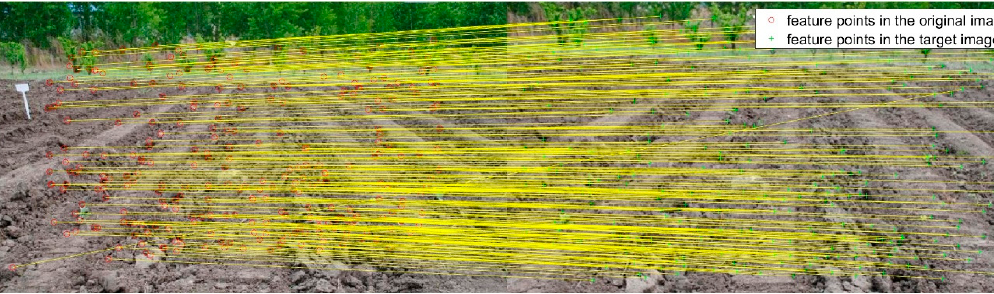
Figure 4. The registration result of SURF − M for target image in Figure 2b.